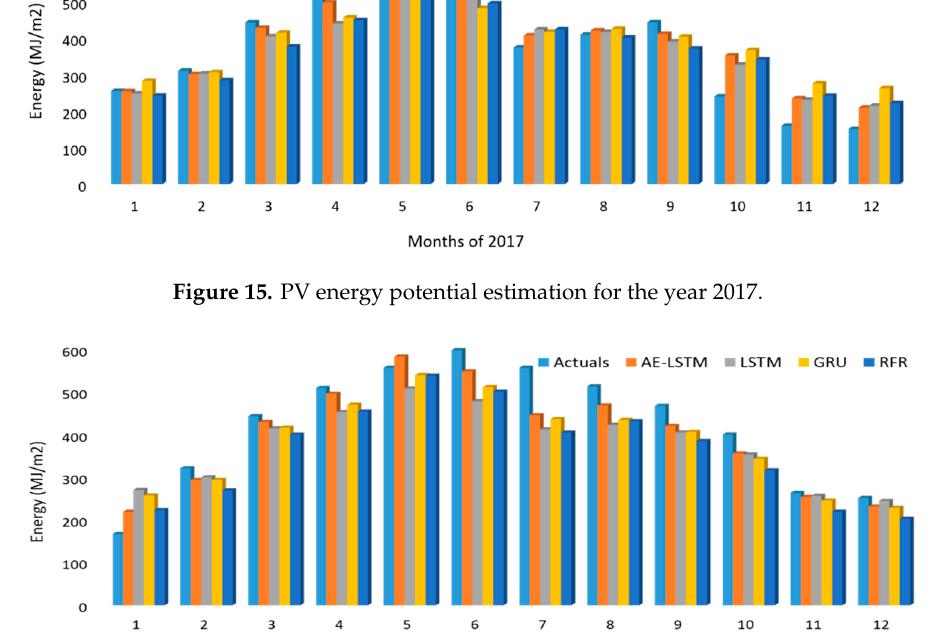
Figure 16. PV energy potential estimation for the year 2018.